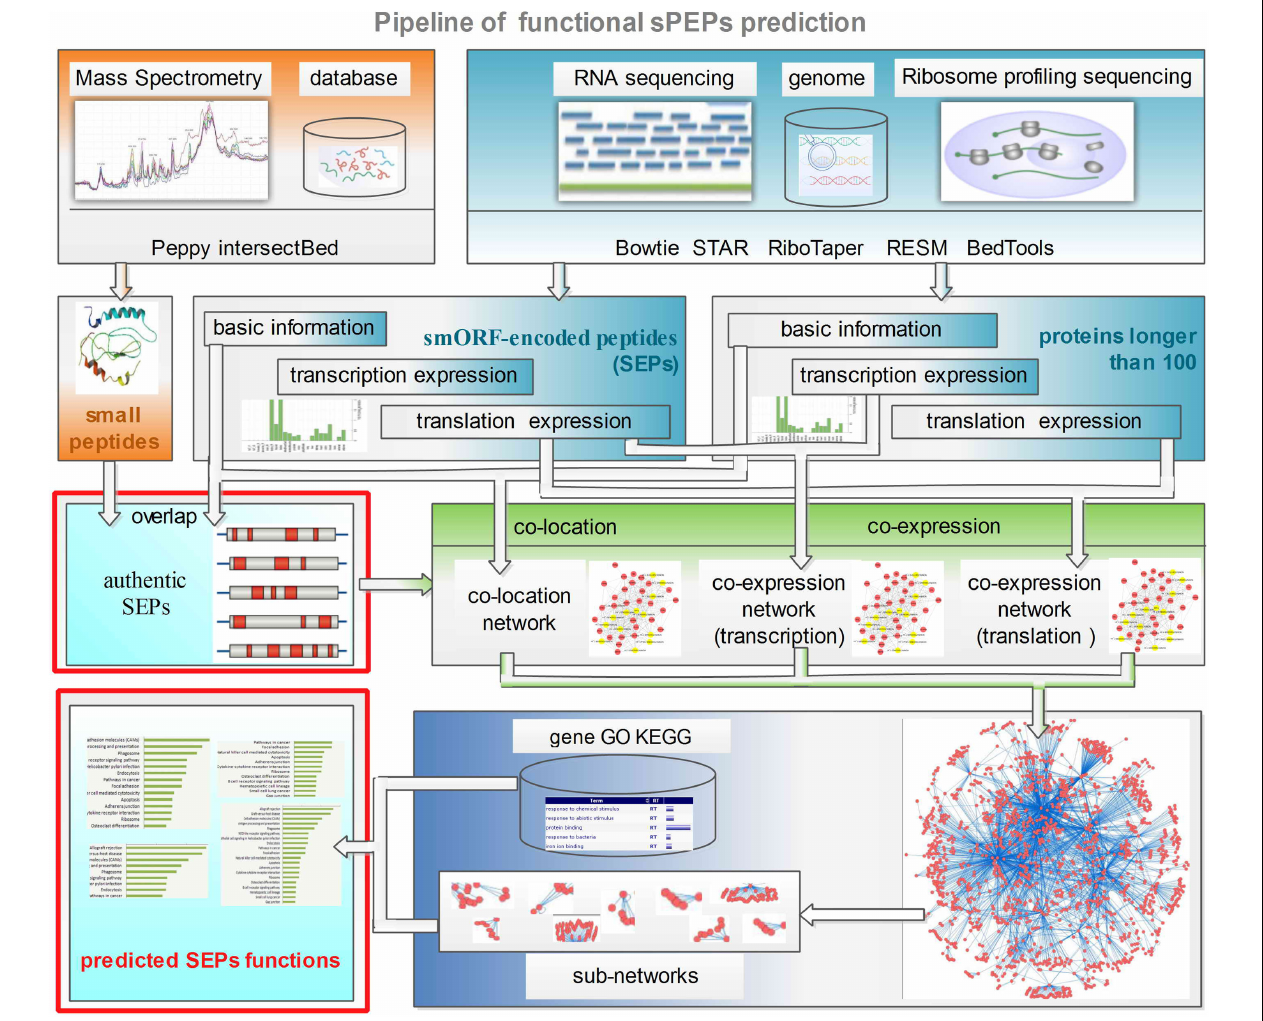
FIGURE 1 | Pipeline of FSPP. Ribo-seq, RNA-seq and mass spectrometry data are input into FSPP. This tool integrates RiboTaper, Peppy etc. to analyze the three kinds of input and gets the fundamental and expression information of translated products. FSPP uses the overlap results of MS and Ribo-seq as the authentic target SEPs. Co-expression relevance and co-location information are used to build up the relation networks. FSPP selects the sub-networks which are significantly related with the target SEPs and annotate the SEPs’ functions with the help of the known neighbors. FSPP, functional smORF-encoded peptides predictor; MS, mass spectrometry; SEPs, smORF-encoded